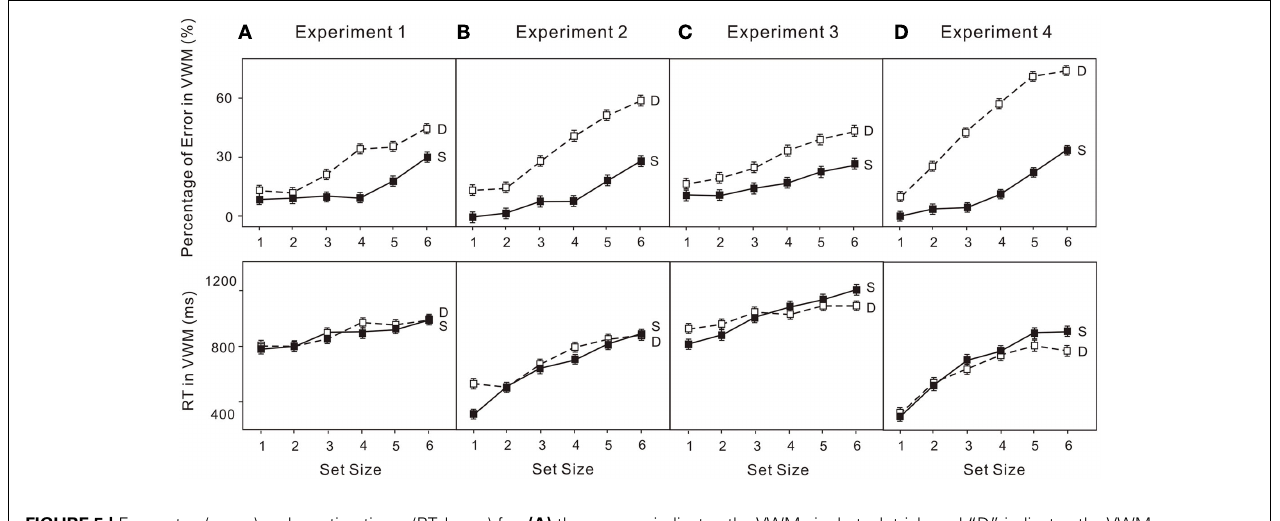
FIGURE 5 | Error rates (upper) and reaction times (RT; lower) for: (A) the VWM task (change detection) in Experiment 1; (B) theVWM task (location recall) in Experiment 2; (C) theVWM task (change detection) in Experiment 3; (D) theVWM task (location recall) in Experiment 4. “S”